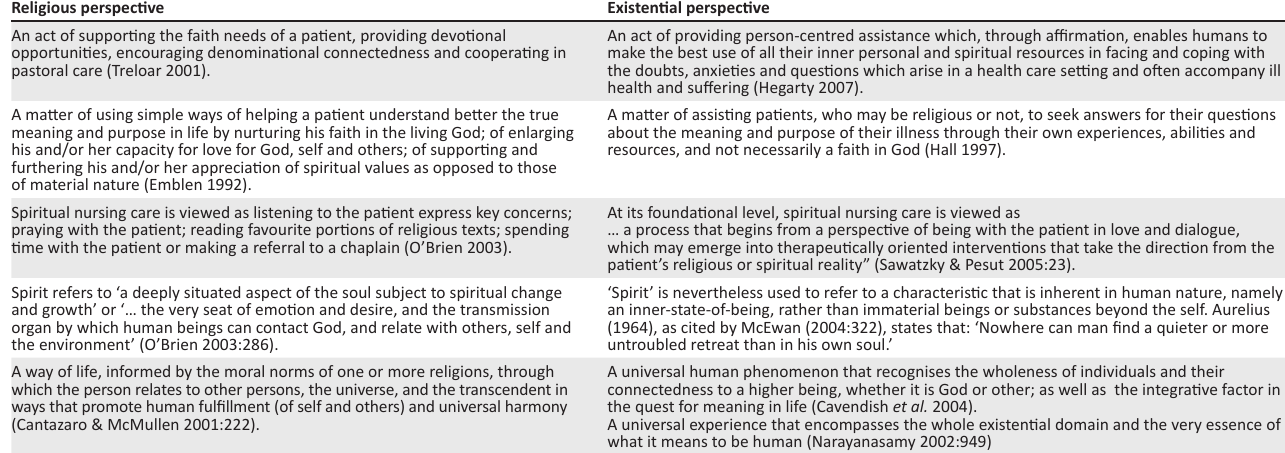
TABLE 1: Definitions of spiritual nursing care. Religious